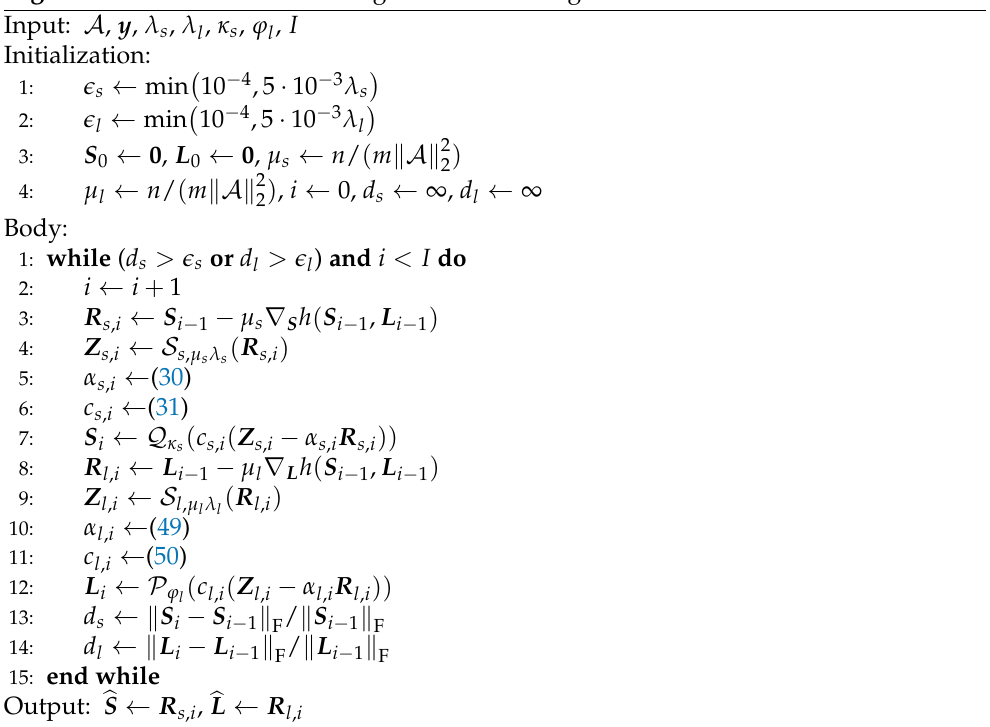
Algorithm 5 Part 1 of TCRPCA algorithm delivering convex